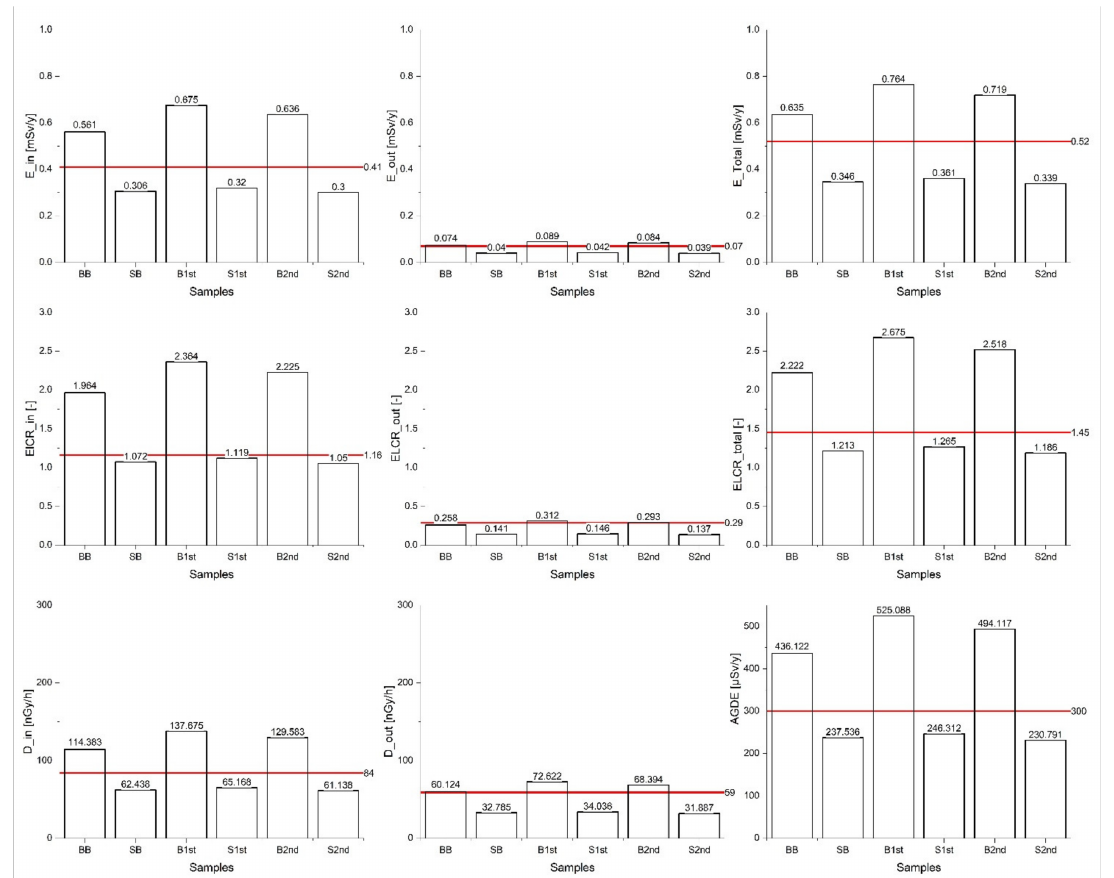
Figure 11. Comparison of the dose parameters with the world average values (represented by red